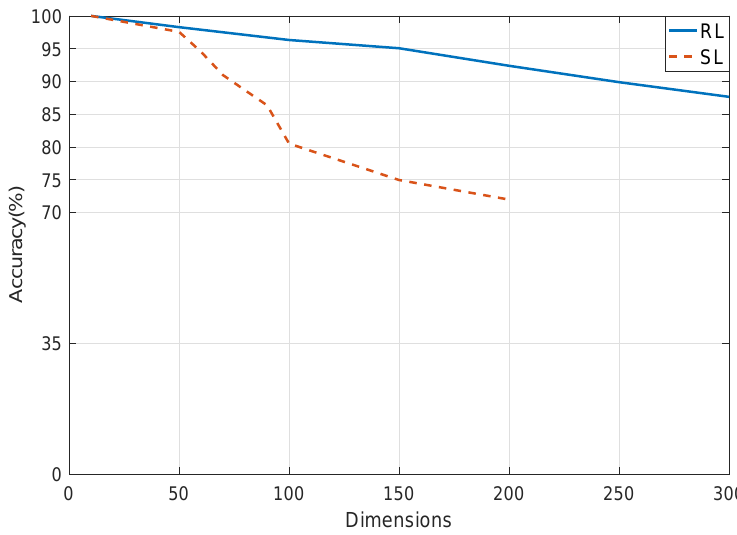
Figure 5. Average accuracies of SL and RL.